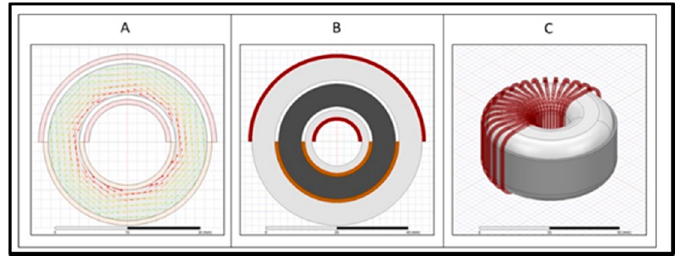
Figure 6. The 180° modified ( A ) flux pattern in core; ( B ) 2D model; ( C ) 3D model.